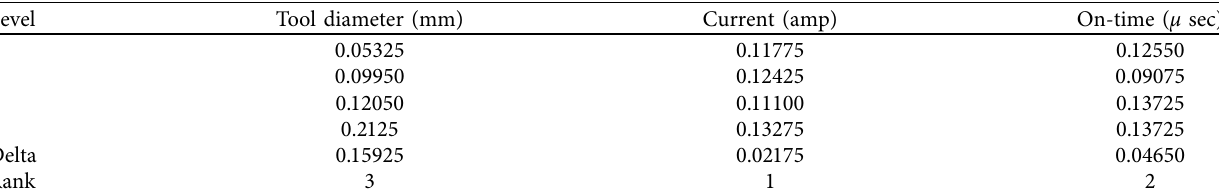
Table 8: MRR and TWR obtained during EDM of Al-B